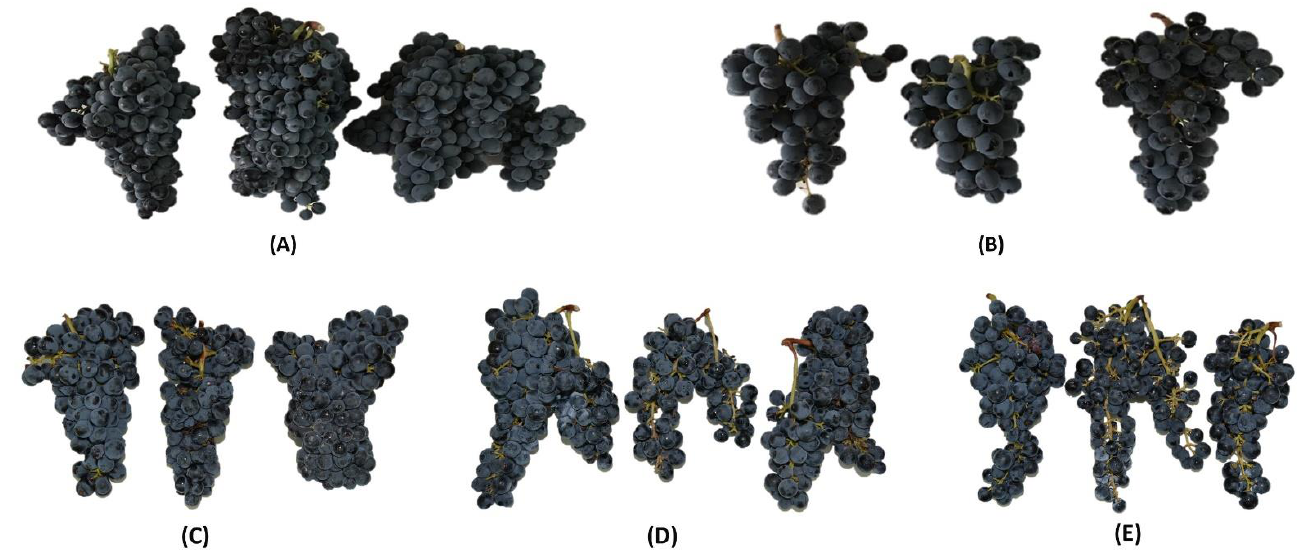
Figure 1. Visual appearance of bunches for each experiment: ( A ) compact bunch, ( B ) non-compact bunch, ( C ) control, ( D ) 25% Berry thinning method, and ( E ) 50% berry thinning method.